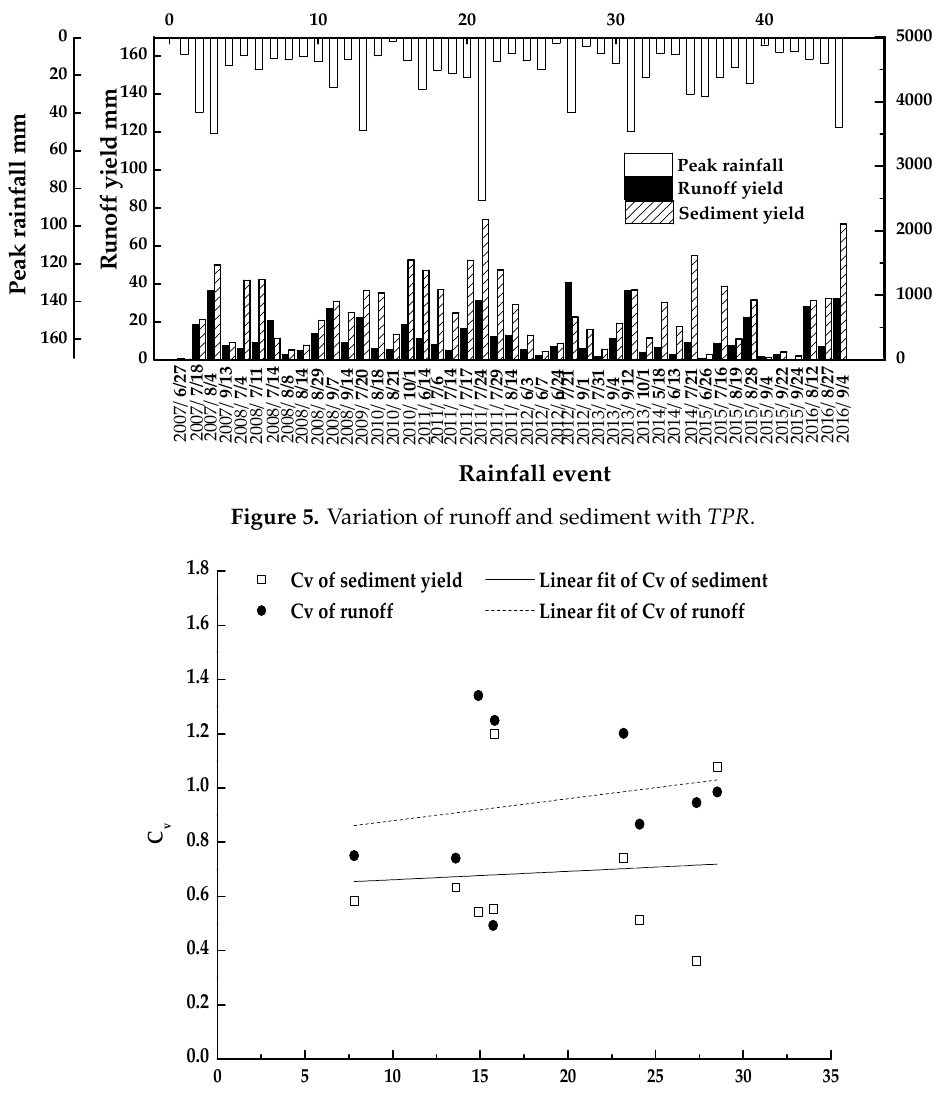
Figure 6. Change in the C v of the annual runoff and sediment yield with the total peak rainfall amount of one rainfall ( TPR ).